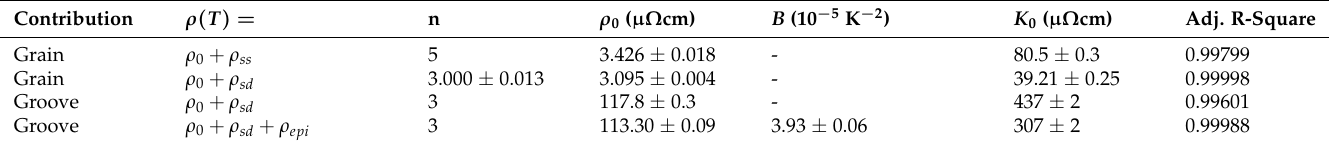
Figure 4. (Color online) Temperature-dependent resistivity for the grain contribution. In panel ( a ), the red line is the fitting for n = 5 in Equation (4) up to 150 K, whereas ( b ) shows the fitting for n as a free parameter for same equation. The upper and lower insets for both panels show the R-square coefficient versus the upper limit of temperature T max and the relative fit error versus temperature, respectively. Table 2. ρ ( T ) fittings for the grain and groove